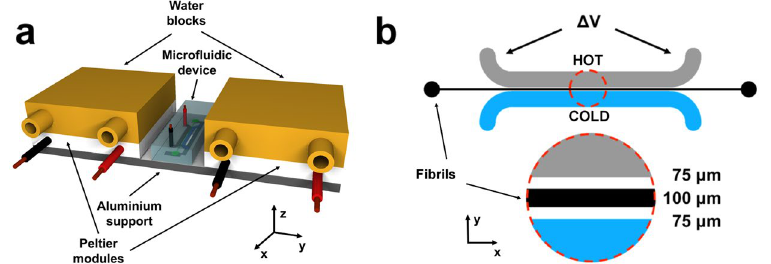
Figure 1. Schematic of the experimental setup for thermophoresis. ( a ) The microfluidic device is placed on an aluminium support, whose temperature is controlled by two separate Peltier modules and two water blocks are used as heat sink in conjunction with a temperature controlled water bath. ( b ) Detailed view of the microfluidic channel: a 30 mm long, 100 µ m wide microchannel contains the fluorescent β -lactoglobulin fibrils, two larger (1 mm width) channels, separated by a 75 µ m layer of polydimethylsiloxane (PDMS) from the microchannel, are used as heater (where ∆ V is the potential applied to the Joule heater) and cooler to impose a temperature gradient. The whole device has a thickness of 120 µ m.